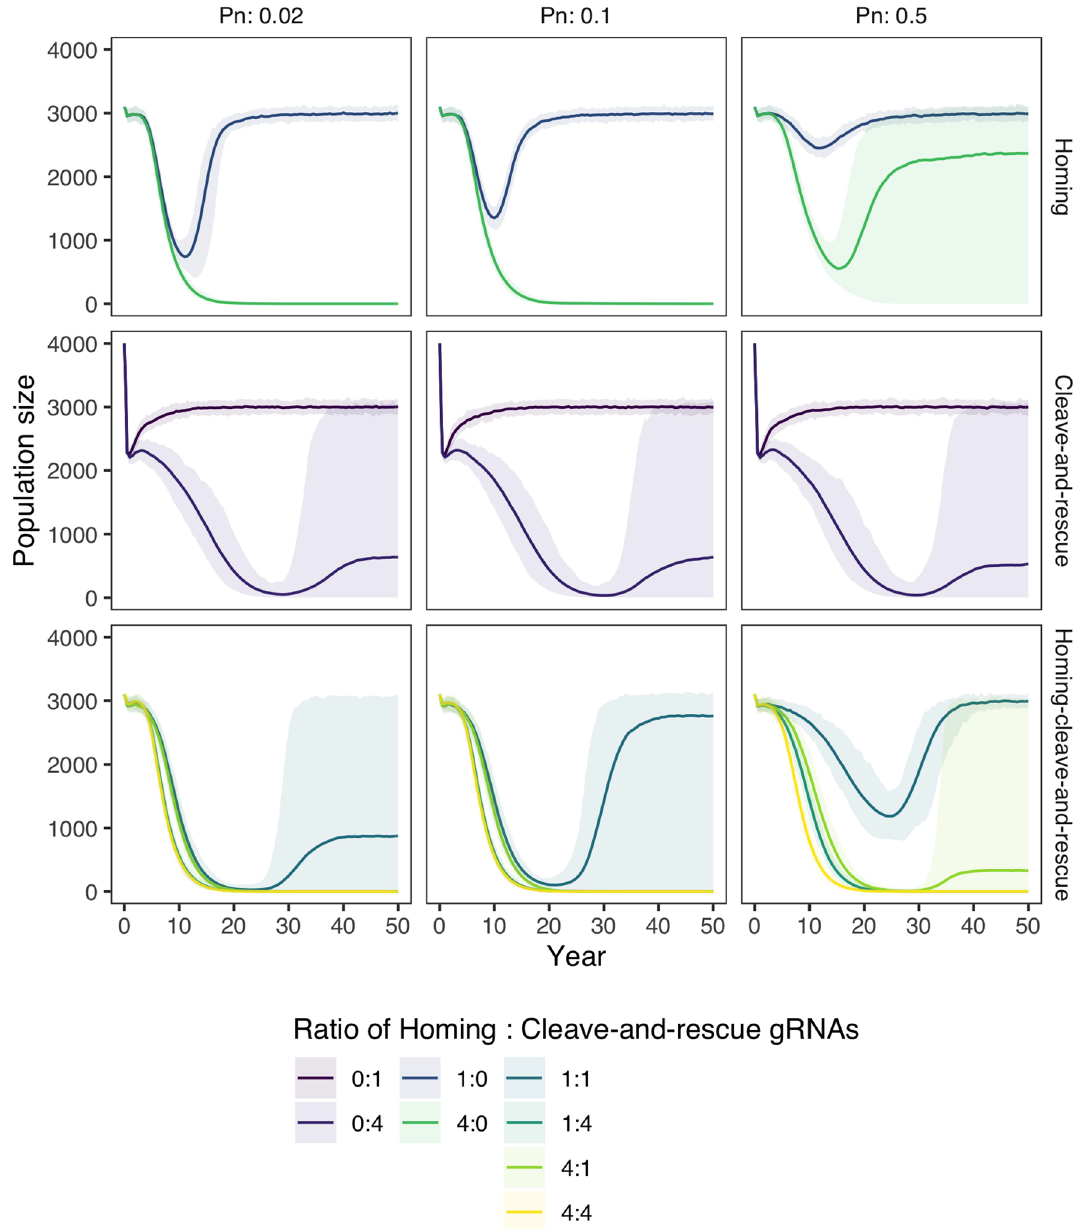
Figure 3. Population size over time after the introduction of gene drive squirrels with either a standard homing, a standard cleave-and-rescue, or a homing-cleave-and-rescue gene drive to a population with carrying capacity 3000. All simulations are based on a single release of 100 squirrels is done, other than the standard cleave-and- rescue gene drive, which requires a release of 1000 squirrels. Lines represent the average population size over 100 model replications, while opaque ribbons represent the 95% quantiles. The model was run with 3 different rates of NHEJ repair during homing ( P n ) and with different numbers of gRNAs for the homing and the cleave- and-rescue components of the gene